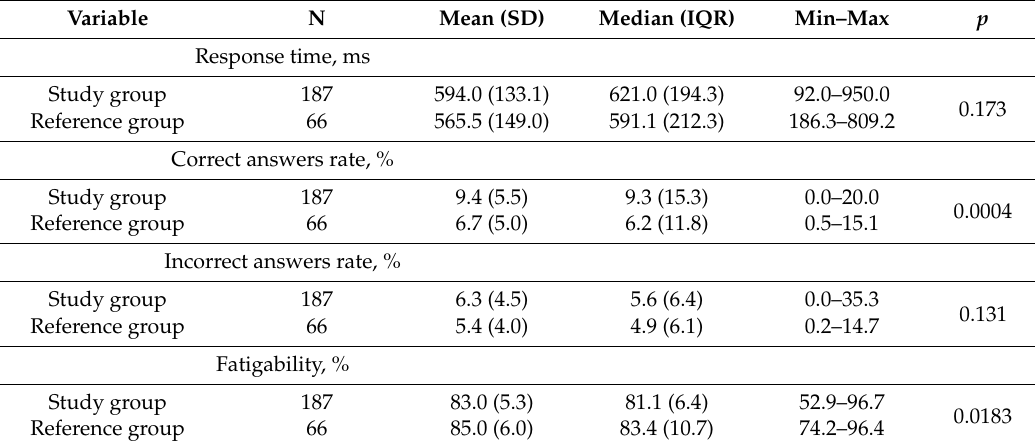
Table 4. Comparison of cognitive parameters between the study and reference group during 12 months of the